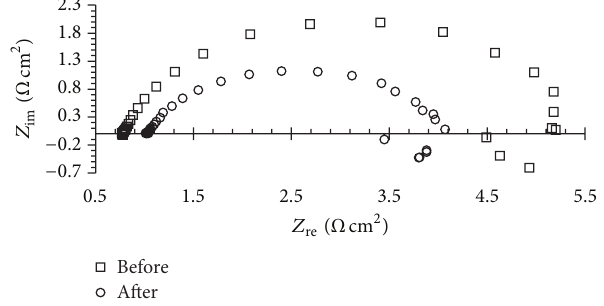
Figure 5: Potentiodynamic behavior of lead and its alloy (0.55% Ag) in zinc electrowinning solution at 40 ∘ C. (a) Pb, (b) Pb-Ag, and (c) Pb-Ag covered with PbO 2